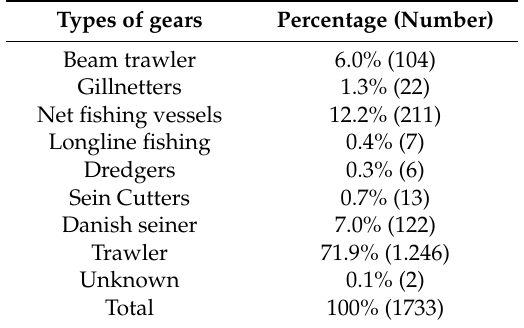
Table 3. Distribution of injuries on different types of vessels in the period